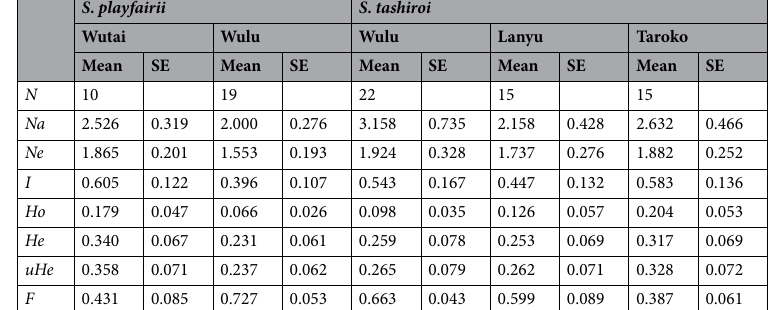
Table 1. Genetic diversity of each sampled population as inferred by 19 microsatellite loci. N , sample size; Na , number of different alleles; Ne , number of effective alleles; I , Shannon’s information index; Ho , observed heterozygosity; He , expected heterozygosity; uHe , unbiased expected heterozygosity, correcting the He using the formula (2 N /(2 N − 1)) × He ; F , fixation index.